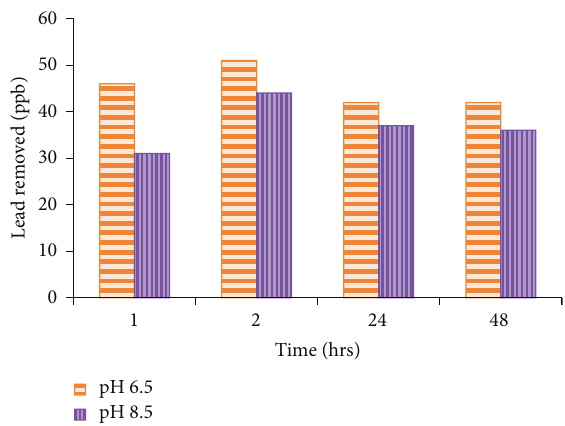
Figure 8: pH analysis of functionalized polyurethane